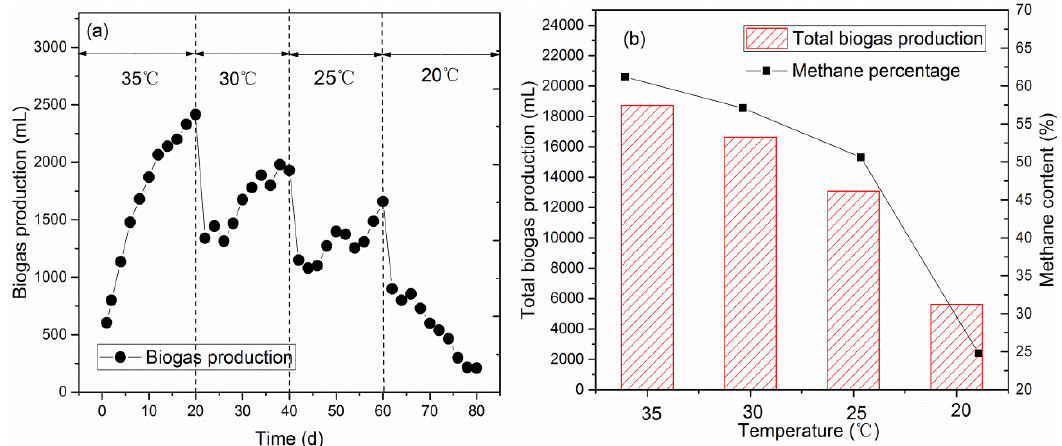
Figure 3. The variety of biogas production at the different temperatures in the methanogenic phase ( a ), and the total biogas production and methane content percentage at different temperatures in the methanogenic phase ( b ).